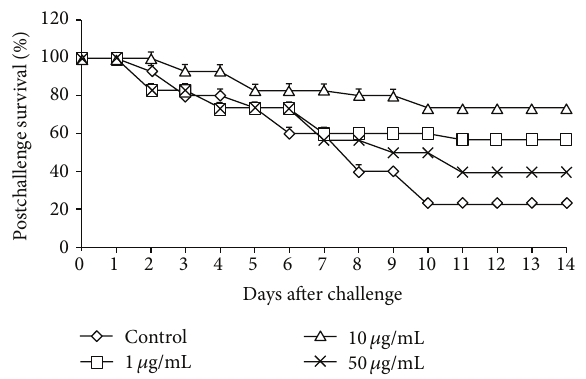
Figure 1: Postchallenge survival after artificial challenging with A. hydrophila in C. idella injected intraperitoneally on different assay days after infection with SA. Bars represent the mean values ± S.E.M ( 𝑛 = 3 ).